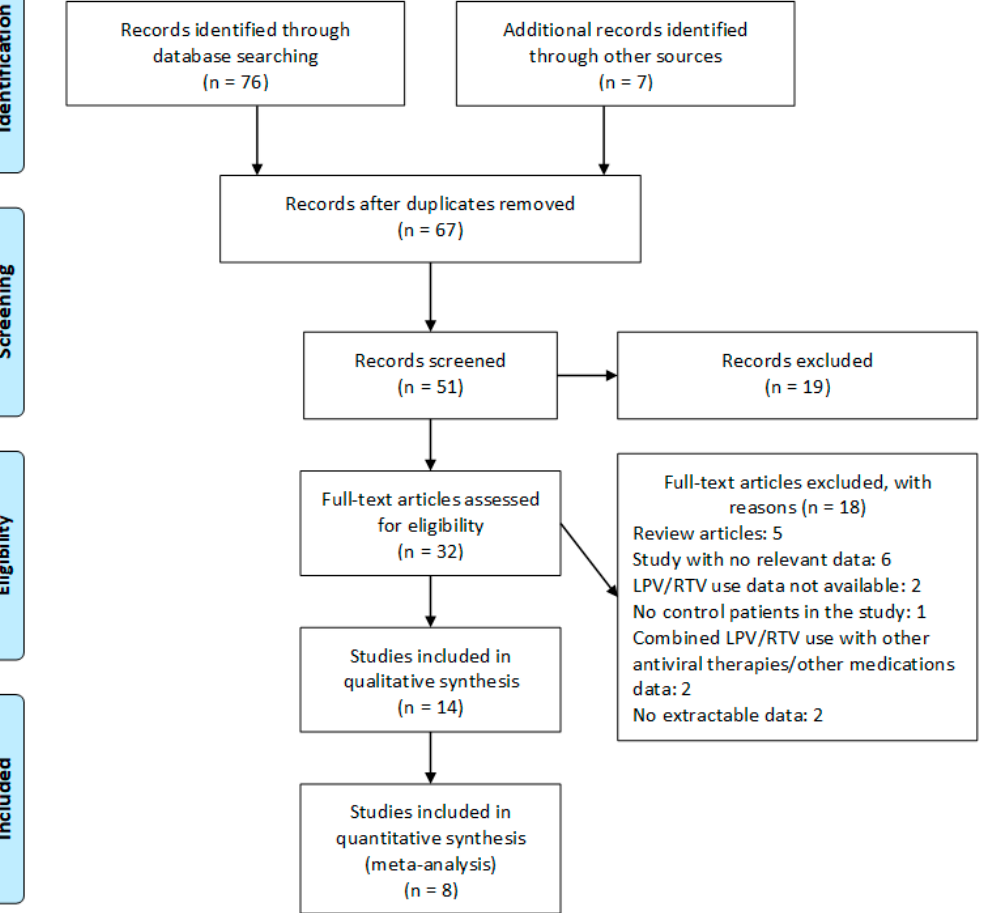
Figure 1. Preferred Reporting Items for Systematic reviews and Meta-Analysis (PRISMA) flow chart of the included studies. LPV/RTV, lopinavir/ritonavir.